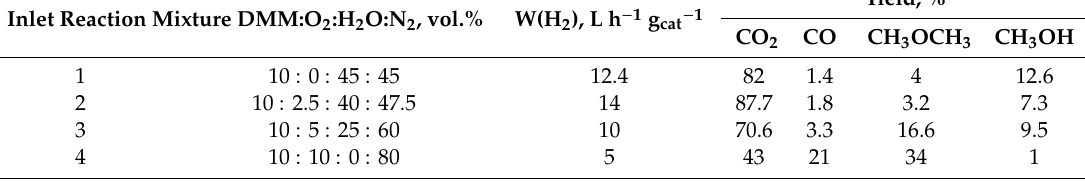
Table 1. Effect of inlet reaction mixture on hydrogen productivity and yield in DMM OSR 1 over the CuO-CeO 2 /γ-Al 2 O 3 catalyst.